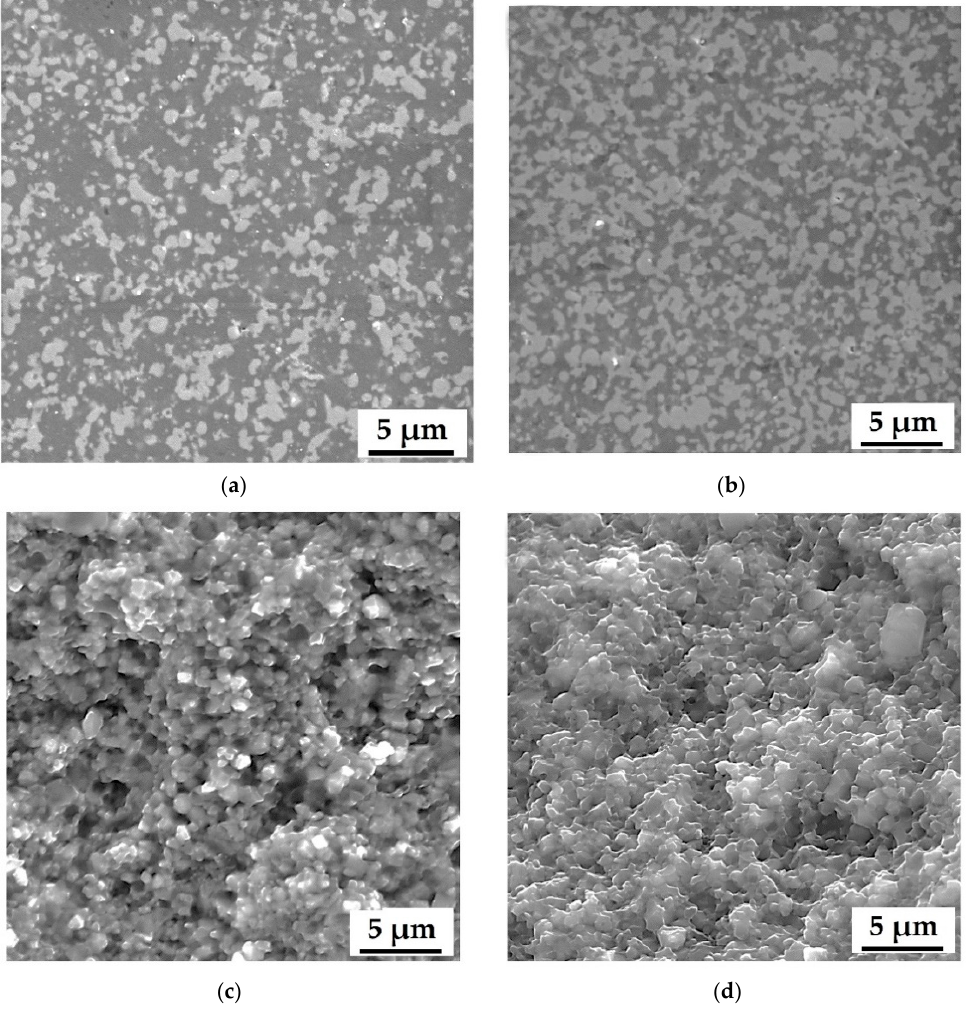
Figure 2. SEM micrographs of Al 2 O 3 -TiC composites: ( a ) polished surface of the sample with 30 vol.% TiC; ( b ) polished surface of the sample with 40 vol.% TiC; ( c ) fractured surface of the sample with 30 vol.%; ( d ) fractured surface of the sample with 40 vol.%. In the figure, alumina is dark, and TiC is